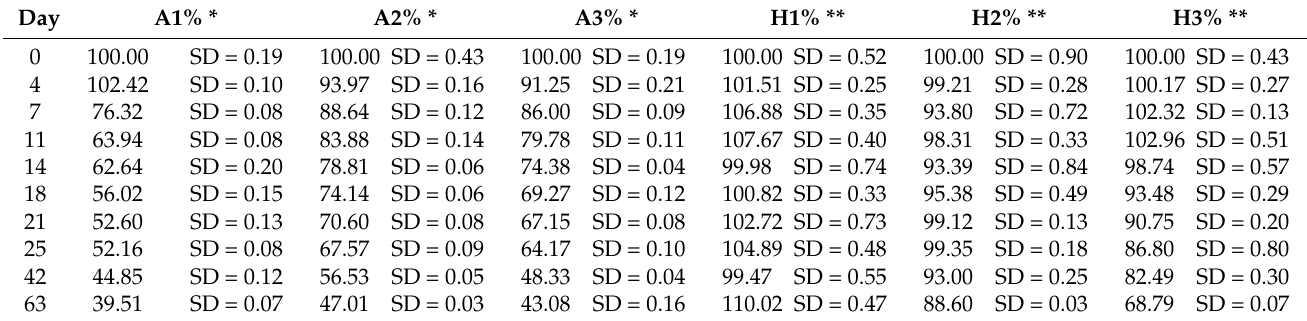
Table 3. Percent residual TC in solutions and hydrogels based on HPLC analysis, * n = 5, ** n =